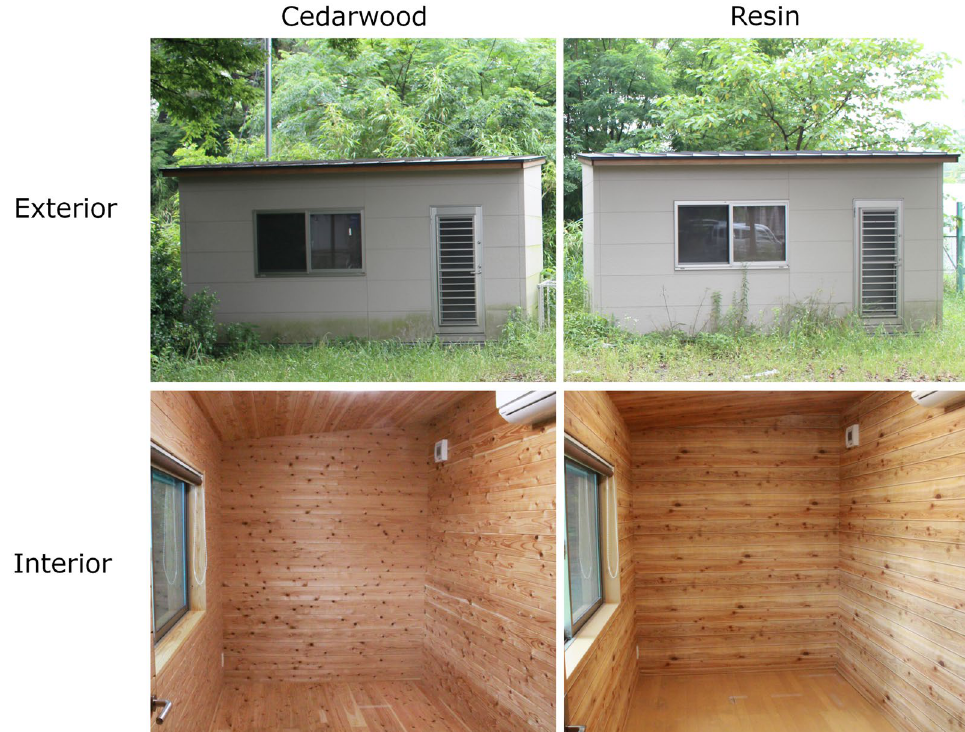
Fig. 1 Exterior and interior of the experimental huts. The interiors of both huts had a similar wood-grain appearance, but the interior of the resin-material hut was covered with wood-grain vinyl cloth to avoid visual effects. During the experiments, the window in each hut was covered with blackout curtains to prevent the effects of sunlight on the participants’ vision (see Additional file 1: Fig.